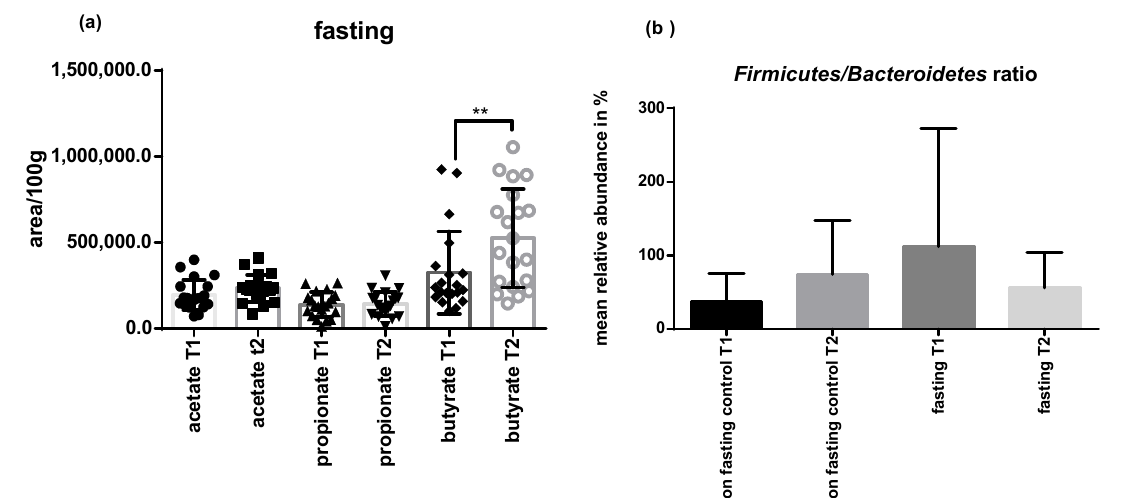
Figure 6. PF increased levels of butyrate and changed Firmicutes/Bacteroidetes ratio. Short-chain fatty acids (SCFAs) amount comparison of fasting group T1 versus T2 ( a ) Firmicutes/Bacteroidetes ratio increased for the non-fasting group and decreased after PF, although not statistically significant ( b ). The results are expressed as mean +/ − SD. Statistical significance was determined using paired t -test for parametric values and Wilcoxon test for nonparametric values.